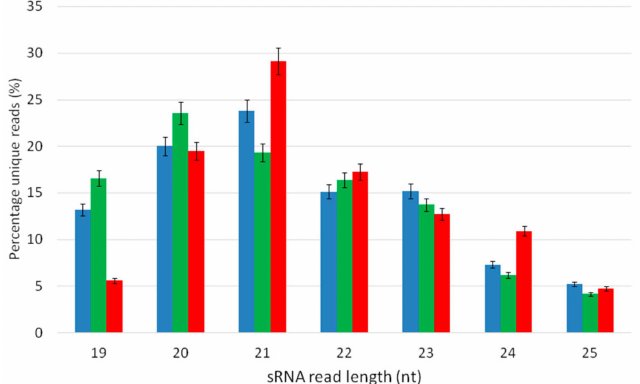
Figure 3. Bar plot depicting the size distribution of unique reads, psRNATarget. Blue—DE, green—DB,